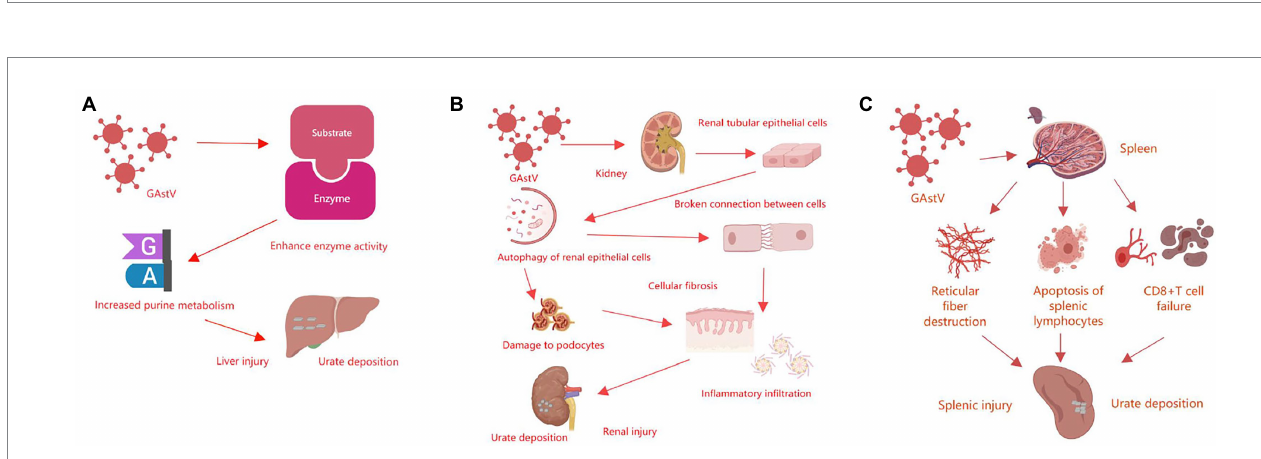
FIGURE 3 Summary of the pathogenic mechanisms of goose astrovirus. (A) Pathogenic mechanisms of goose astrovirus in liver. (B) Pathogenic mechanisms of goose astrovirus in kidney. (C) Pathogenic mechanisms of goose astrovirus in